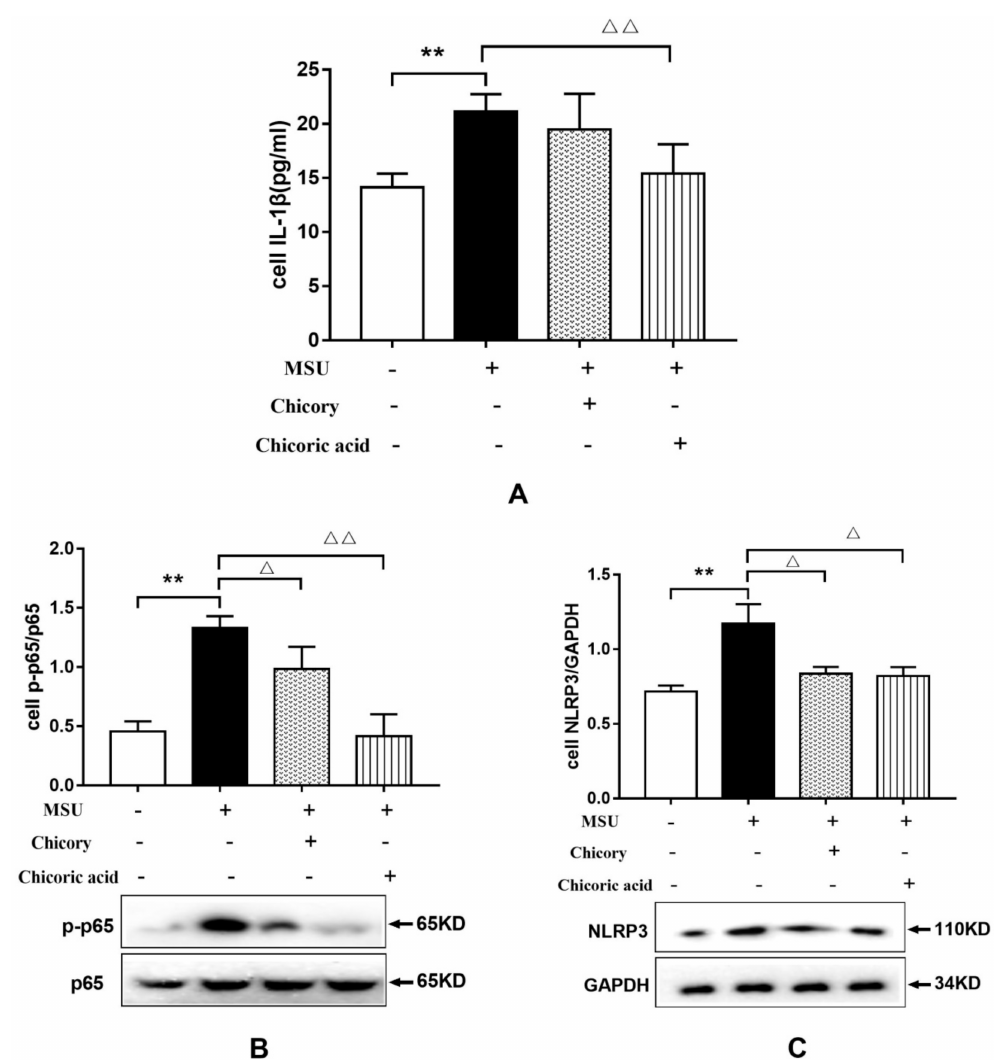
Figure 6. E ff ect of chicory extract and chicoric acid on IL-1 β release and protein expression of p-p65 and NLRP3 in isolated macrophages stimulated with MSU: ( A ) Levels of IL-1 β release, ( B ) protein expression levels of p-p65, and ( C ) protein expression levels of NLRP3. Data are expressed as mean ± SD for three repetitions in each group. * p < 0.05 vs. non-treated group. (cid:52) p < 0.05, (cid:52)(cid:52) p < 0.01 vs. MSU-stimulated